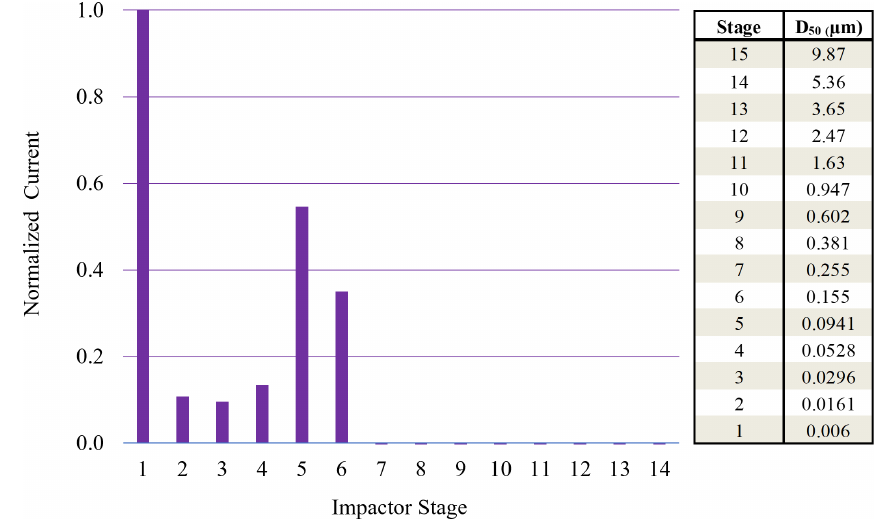
Figure 5. Normalized ELPI current values observed for each impaction stage for 70nm (initial dry diameter) sucrose particles sampled from 95% chamber RH. High stage 1 current indicative of particle bounce.